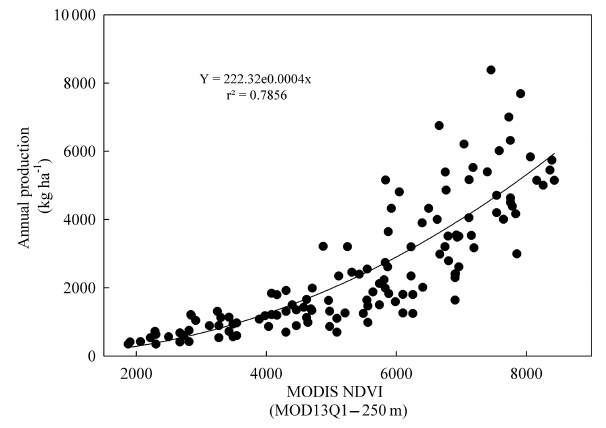
Figure 8. Relationship between annual production and annual max- imum Normalized Difference Vegetation Index (NDVI) on 51 grass- land vegetation